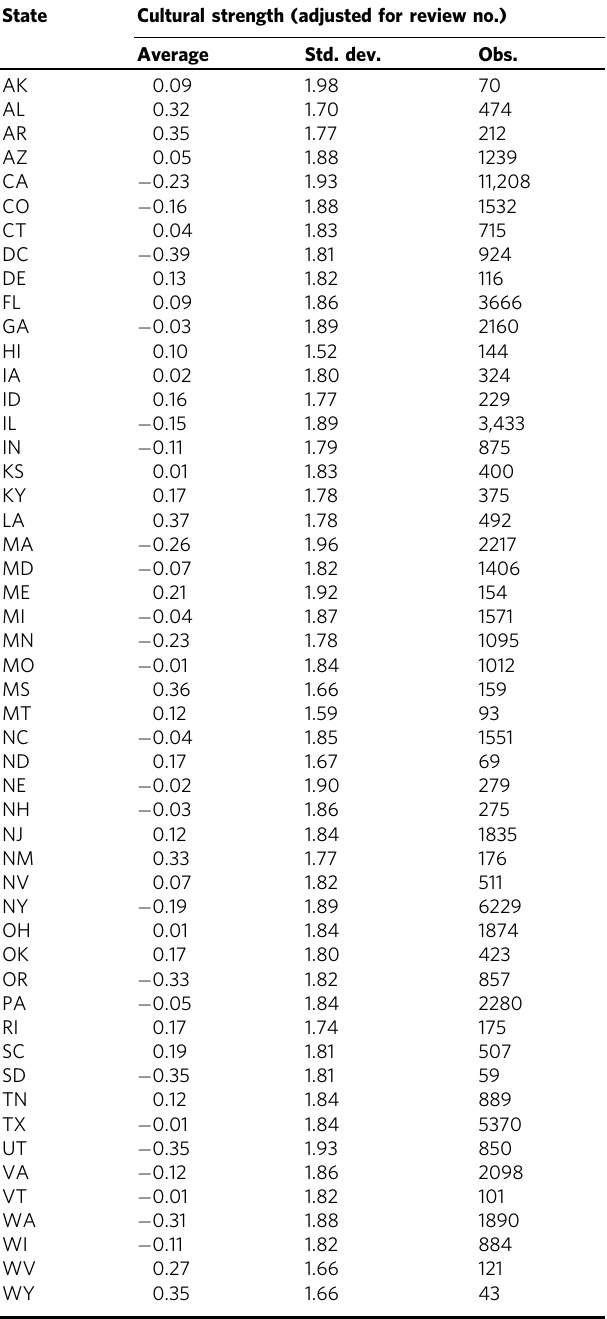
The cultural strength metric used in this table is the residual obtained from regressing Cultural strength on Firm Glassdoor reviews to remove the mechanical correlation existing between the two